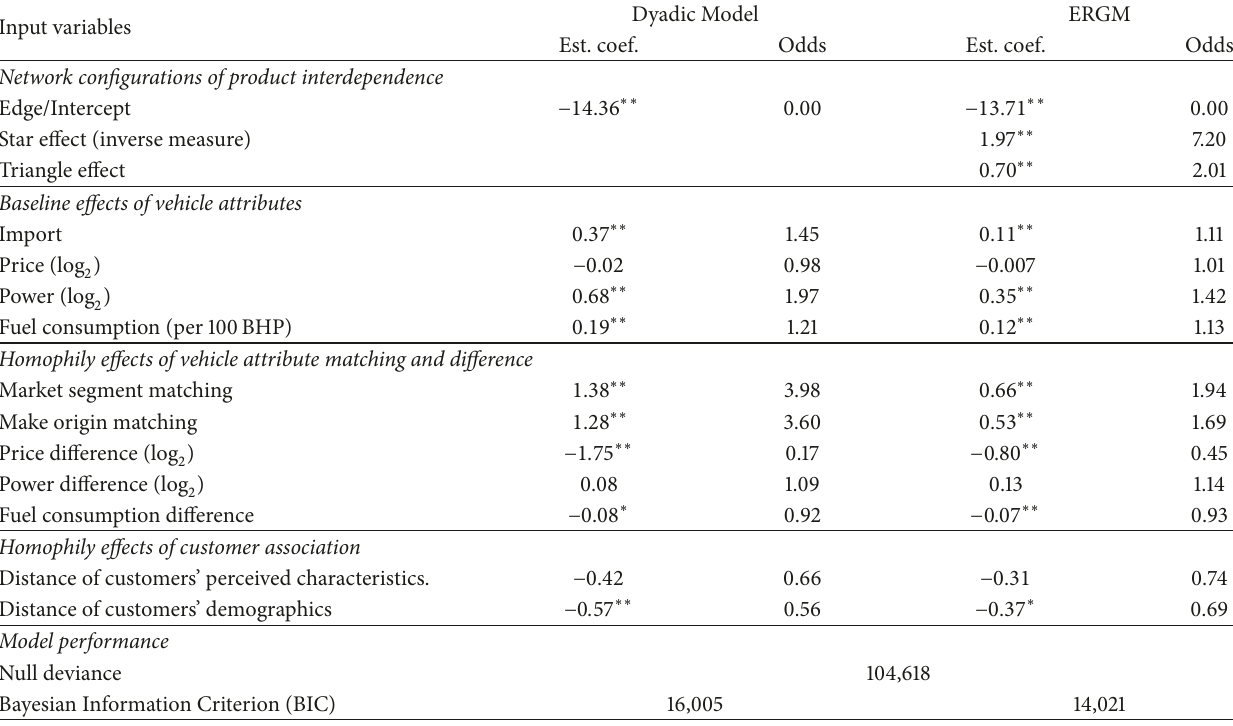
Table 4: Estimated coefficients and odds ratios of the dyadic model and